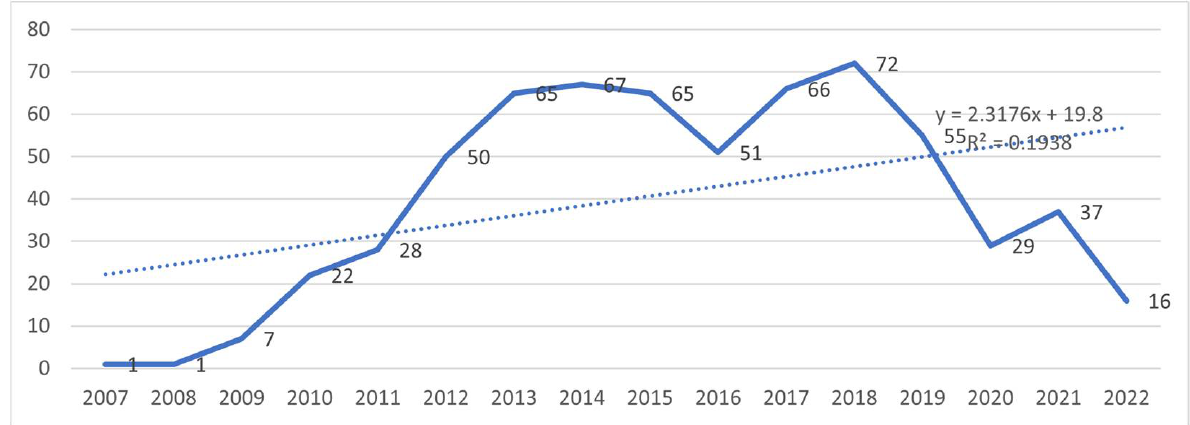
Figure 4. Evolution of the annual scientific production and exponential variation between periods.